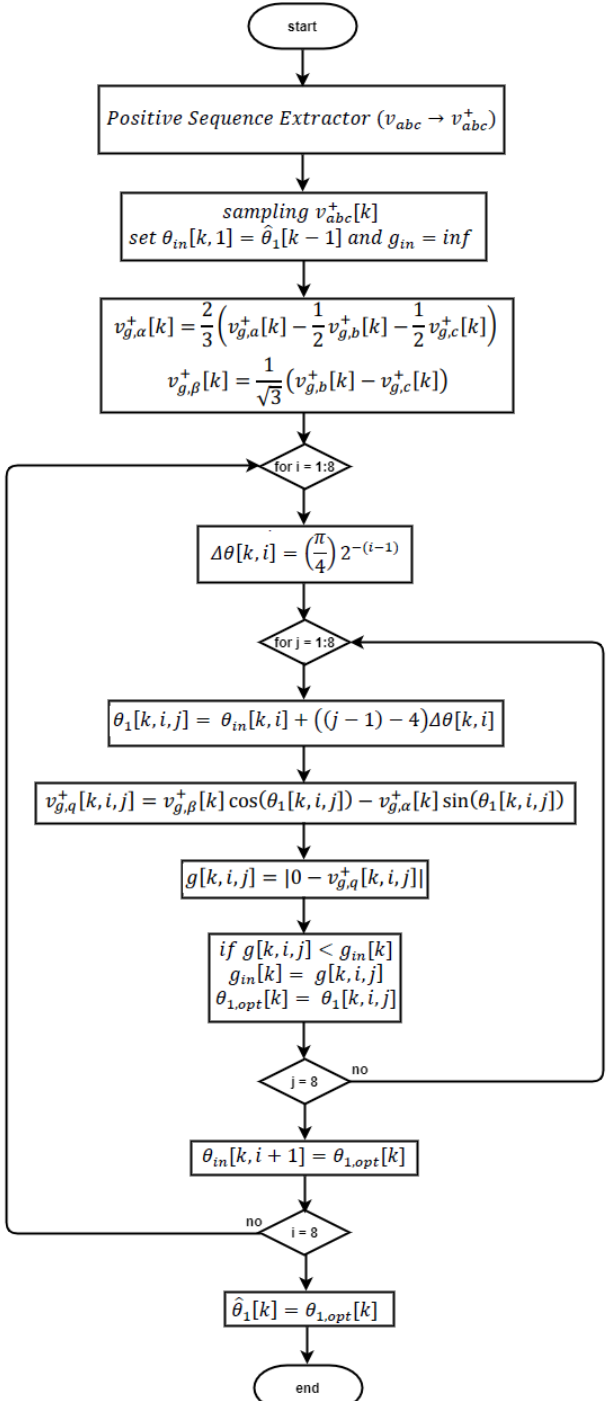
Figure 3. Flowchart of the proposed